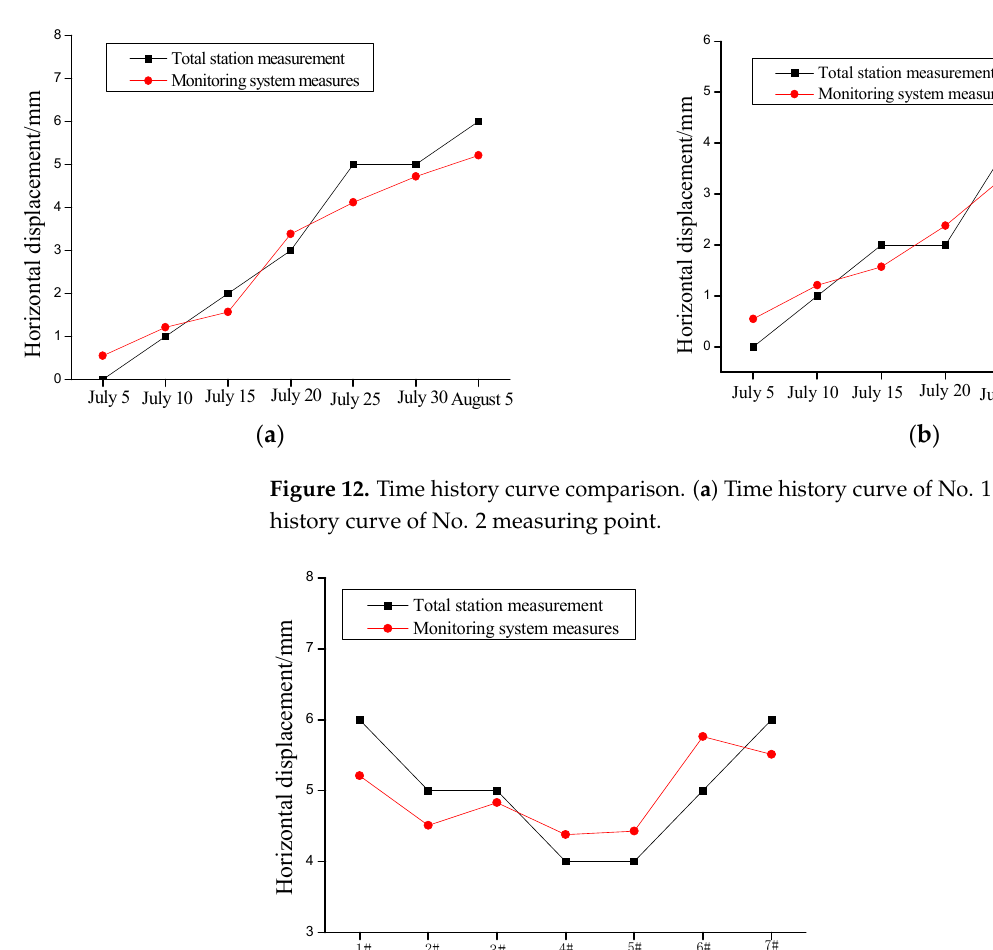
Figure 11. Pull-wire displacement sensor and station.